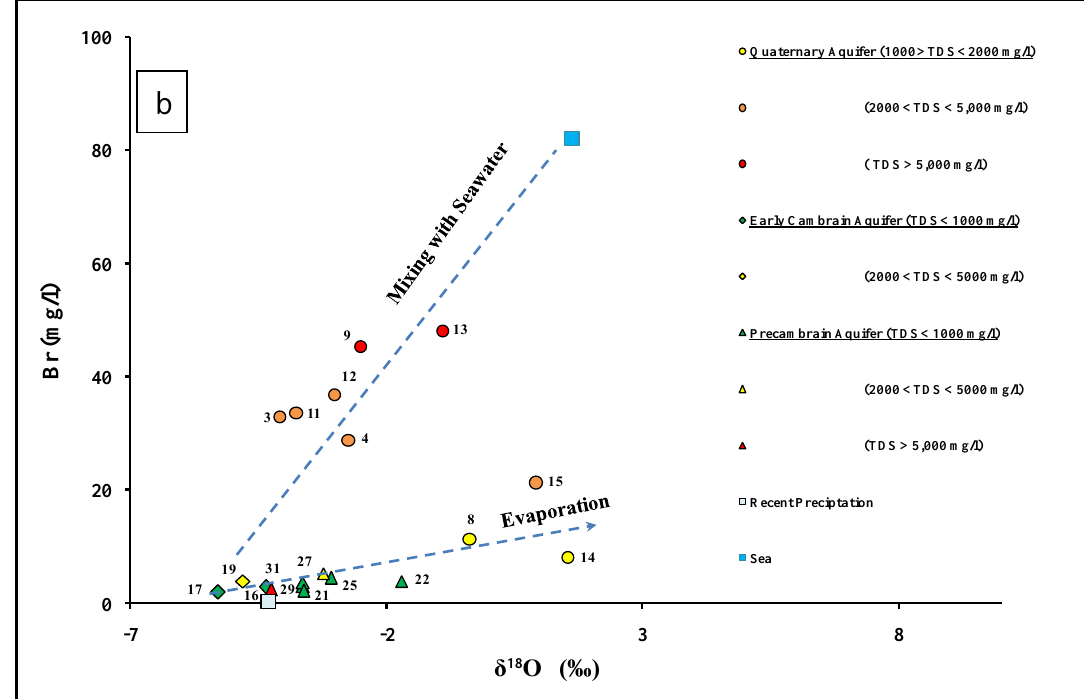
Figure 6. ( a ) δ 18 O versus δ 2 H for groundwater of the Dahab watershed. The rain isotopic value is the amount of weighted mean average from [29,82]; and global meteoric water line after [83]. The paleo-groundwater isotopic data are from [78,79]. ( b ) δ 18 O versus bromide for groundwaters in the Dahab watershed.